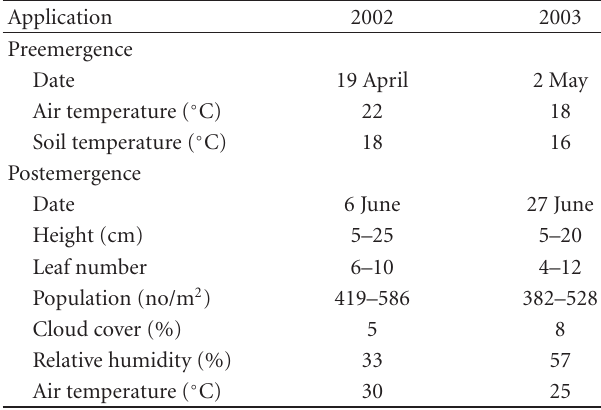
Table 1: Environmental conditions and plant size for preemergence and postemergence applications for field research in 2002 and